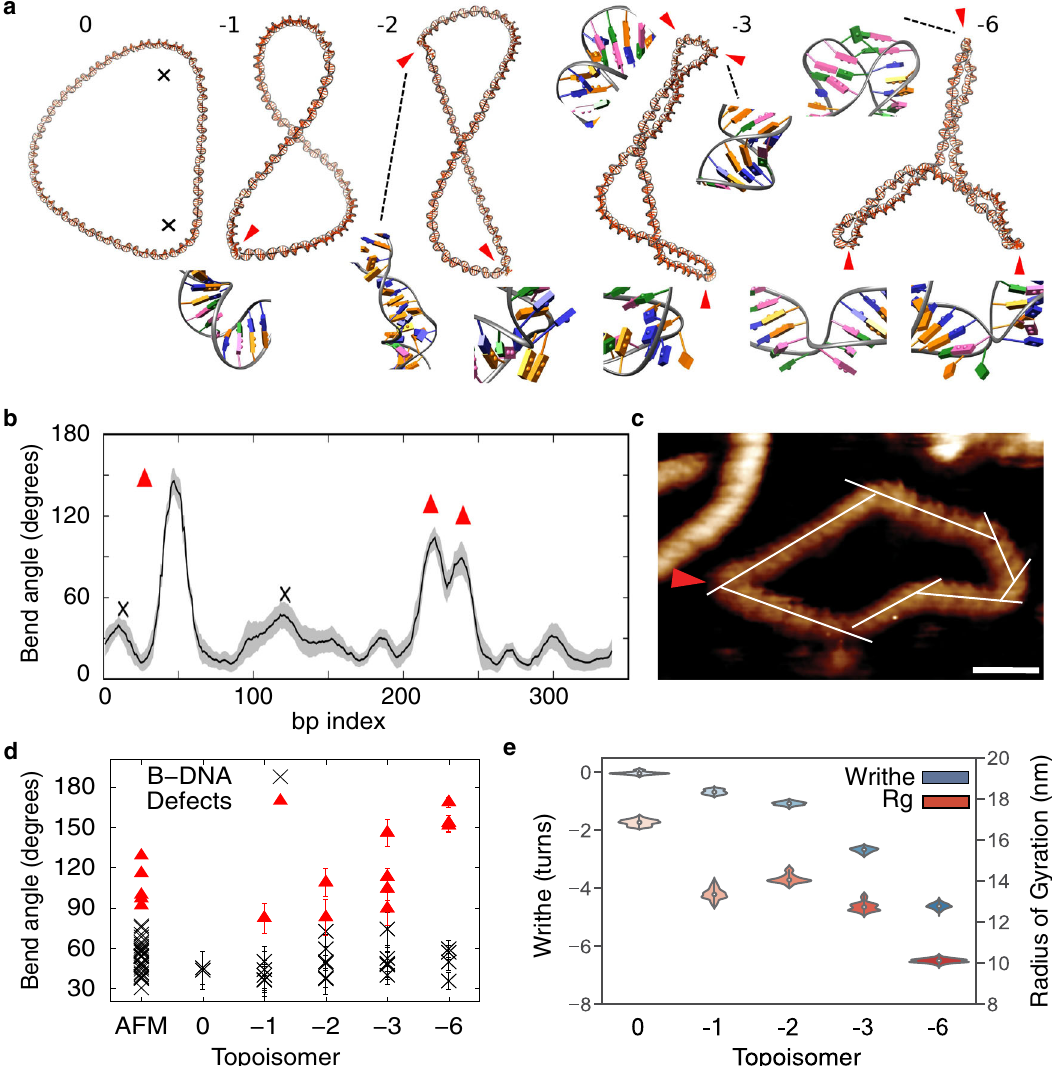
Fig. 2 Supercoiling induces defect formation in 339 bp DNA minicircles, while increasing writhe and compaction. a MD average structures showing increased defect formation at higher supercoiling, the numbers at the top of each fi gure are Δ Lk for each structure. b Bending calculation obtained by the SerraLINE program using the WrLINE pro fi le from the − 3 topoisomer trajectory, where bend angles are calculated as a directional change in tangent vectors separated by 16 bp (additional bending pro fi les in Supplementary Fig. 3). All peaks >35° are classi fi ed as B-DNA bends (black cross) or defects (red triangles) depending on whether canonical non-bonded interactions were broken. c Determination of bending angles in natively supercoiled DNA by high- resolution AFM (white lines), scale bar: 10 nm and height scale 2.5 nm. d Bent-DNA analysis of DNA minicircles by high-resolution AFM (natively supercoiled, fi rst column), and MD simulations (topoisomers 0 to − 6, a ) shows a ≈ 75° cut-off between B-DNA (black crosses) and defects (red triangles), with an increase of the latter with supercoiling. e Radius of gyration (Rg) and writhe for the different topoisomers extracted from MD simulations. Grey shading ( b ) corresponds to standard